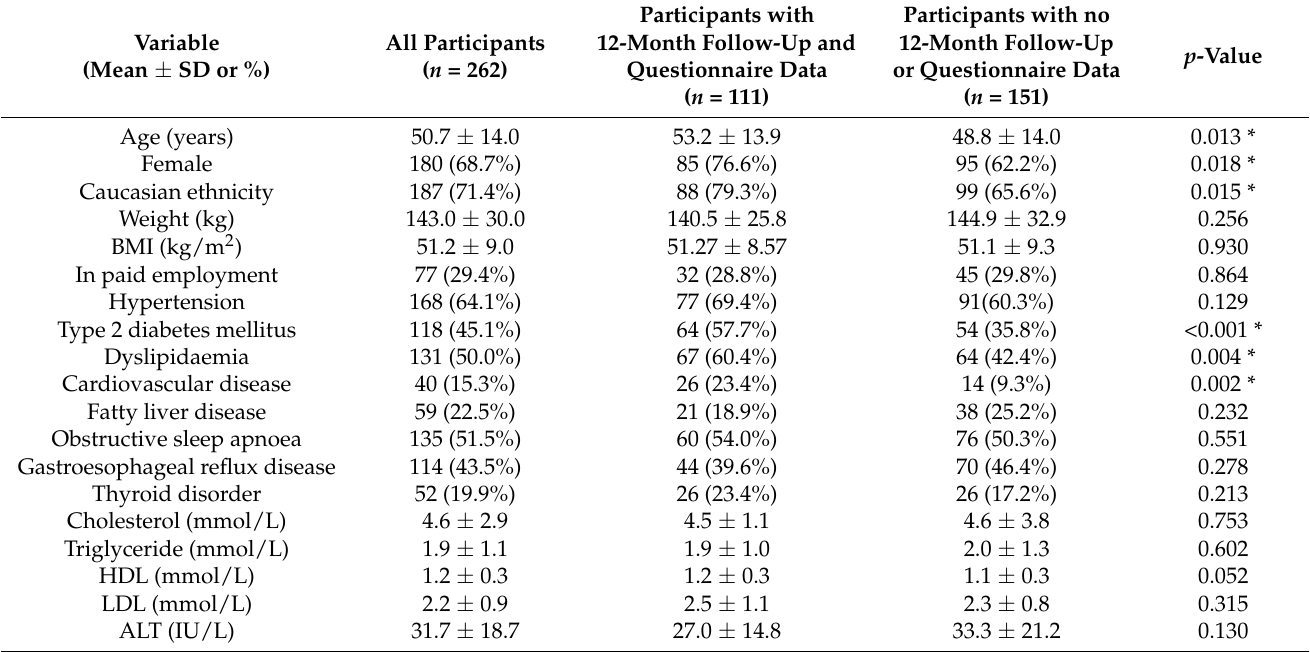
Table 1. Baseline characteristics of the study